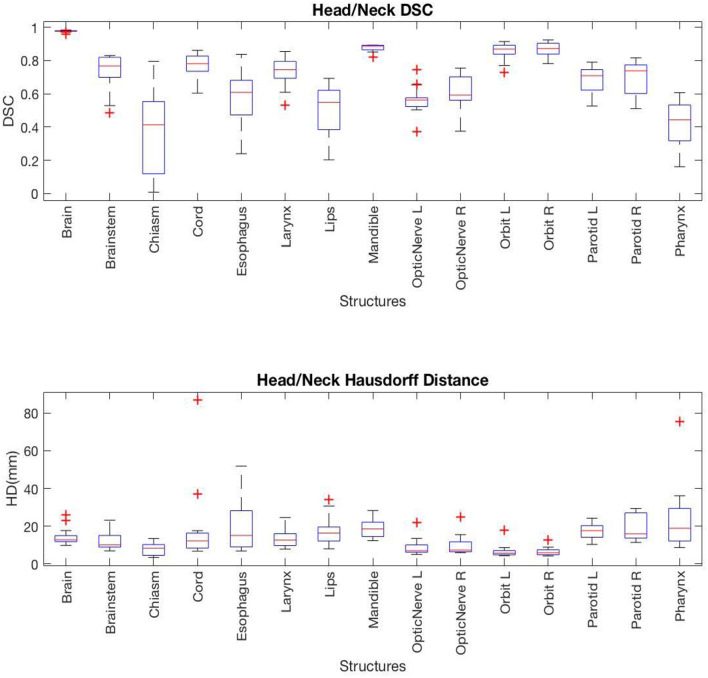
Box plots representing the (Top) DSC and (Bottom) HD for each HN structure.